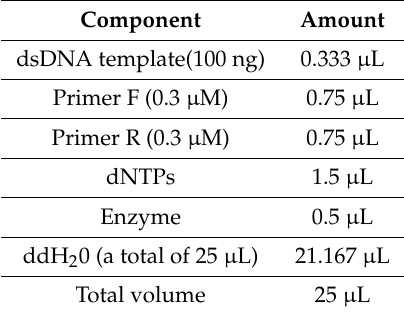
Table 1. Site directed mutagenesis reaction components.